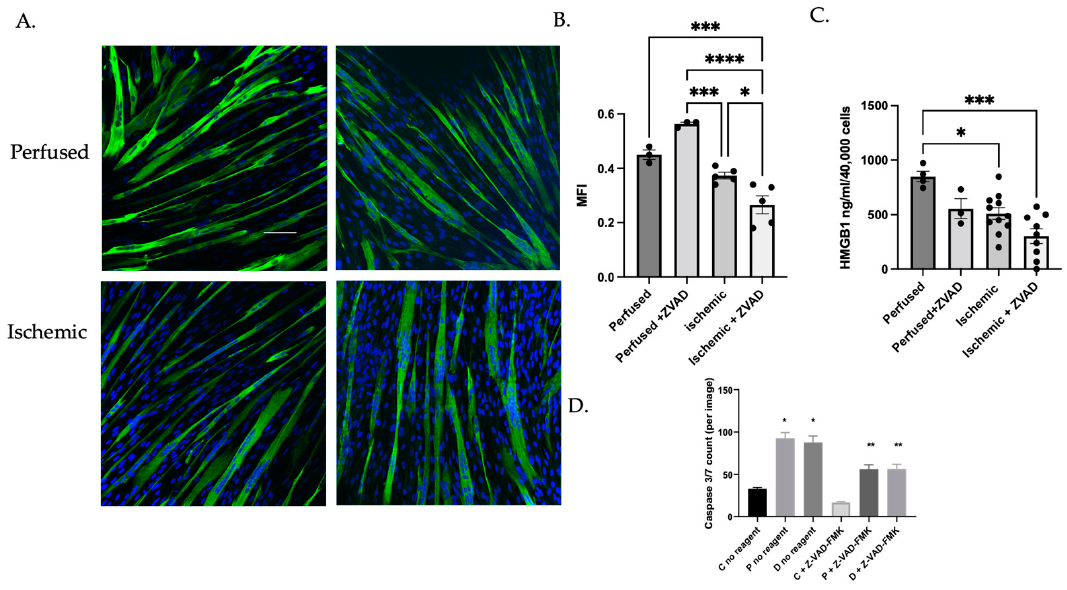
Figure 5. Pan-caspase inhibition attenuated myocyte differentiation in ischemic myoblasts and reduced HMGB1 release during myocyte fusion. Perfused and ischemic (proximal and distal) myoblasts were induced to differentiate in the presence or absence of Z-VAD-FMK. ( A ) Cells were immunostained with antibodies against MF20, which detects myosin heavy chain 2, a marker of differentiation. Nuclei were detected using DAPI, and the myocyte fusion index (MFI) was calculated. ( B ) MFI in perfused and ischemic cells with and without Z-VAD-FMK (* p < 0.05, *** p < 0.001, **** p < 0.001). ( C ) Supernatants were collected and subjected to ELISA to determine HMGB1 concentration (* p < 0.03, ** p < 0.001). ( D ) Incucyte live cell imaging was performed to assess expression of apoptotic markers over time, with and without Z-VAD-FMK, and final count was assessed after five days (* p < 0.03, ** p < 0.01). Scale bar = 10 μ M.